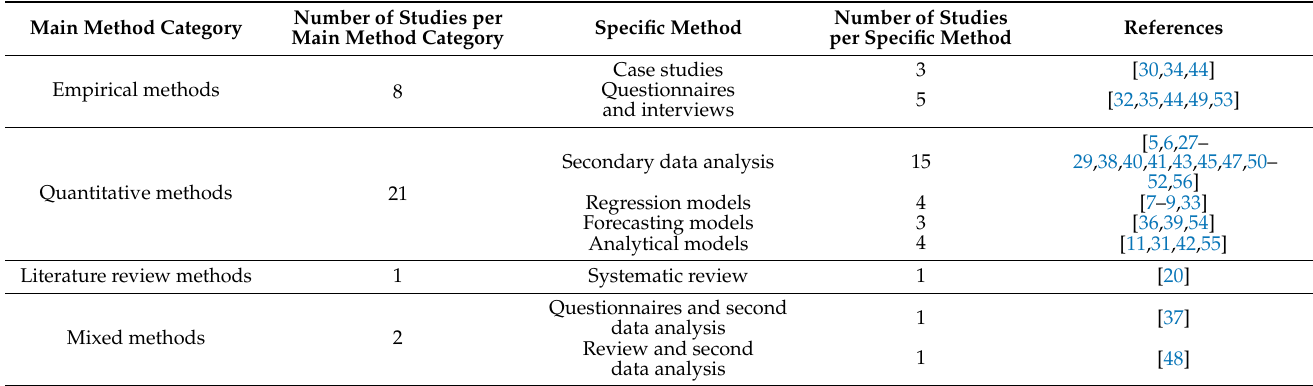
Table 6. Classification of studies on the impact of COVID-19 based on research